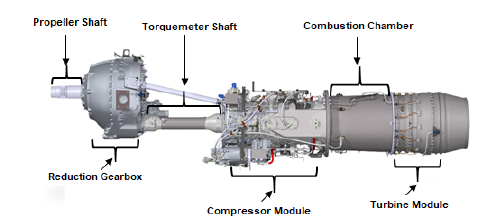
Figure 1. The main components of turboprop engine